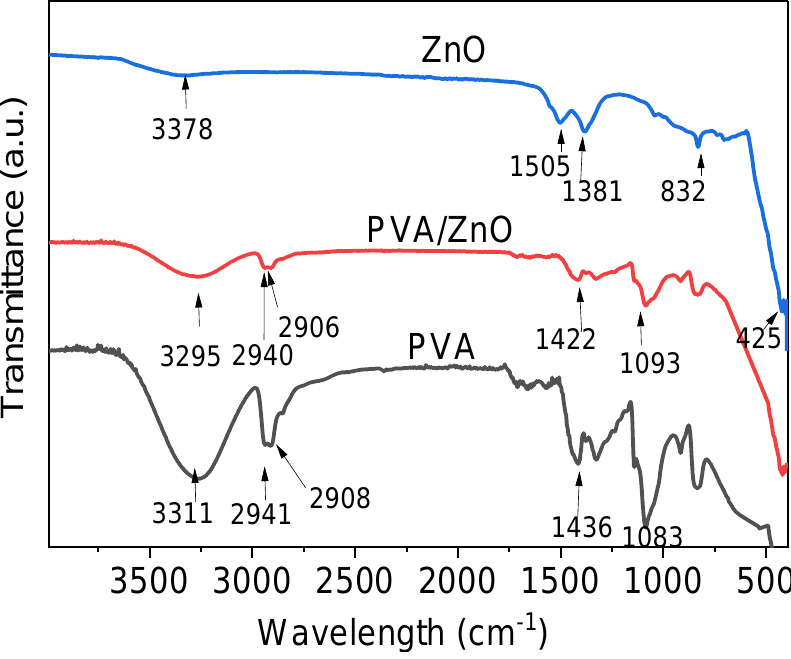
Figure 4. FTIR (Fourier-transform infrared) spectroscopy of zinc oxide nanoparticles (indicated by the blue line), PVA (indicated by the black line), and PVA/ZnO (indicated by the red line).